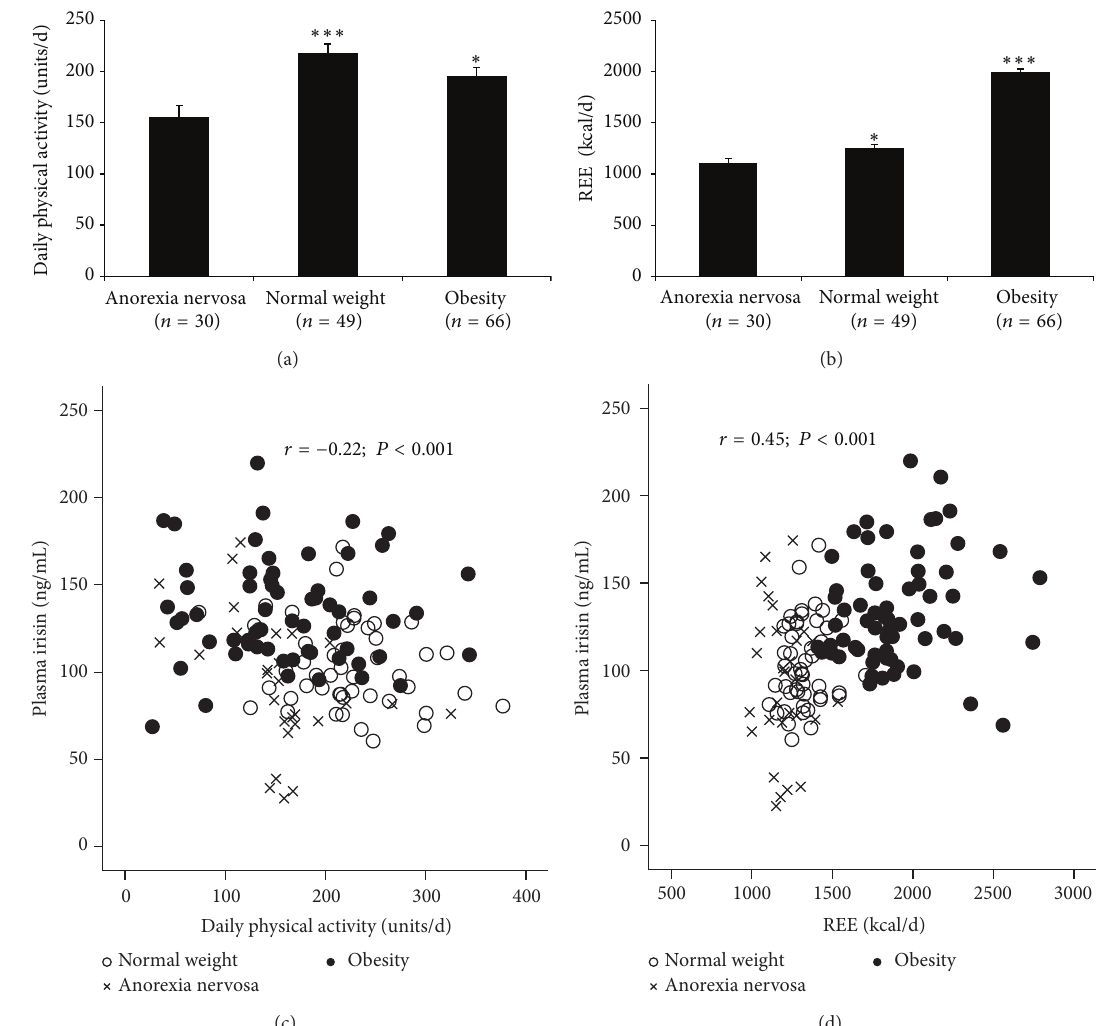
Figure 3: Daily physical activity and resting energy expenditure and its correlation with irisin. The average daily physical activity (units/day) and resting energy expenditure (REE: kcal/day) for the AN, NW, and OB subjects are shown in (a) and (b), respectively. Asterisk ( ∗ 𝑃 < 0.05 and ∗∗∗ 𝑃 < 0.001 )denotesstatisticallysignificantdifferencesbetweennormalweightandanorexianervosaorobesityversusanorexianervosa and normal weight. The correlations between the circulating irisin and the daily physical activity and REE for the three groups are presented in (c) and (d).